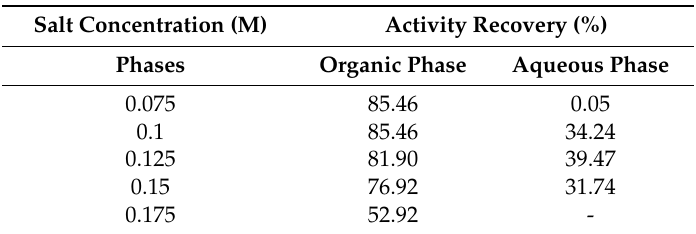
Table 3. Effect of the ionic strength on the forward extraction (organic phase) and the backward extraction (aqueous phase) in the Triton X-100/toluene reverse micelles.